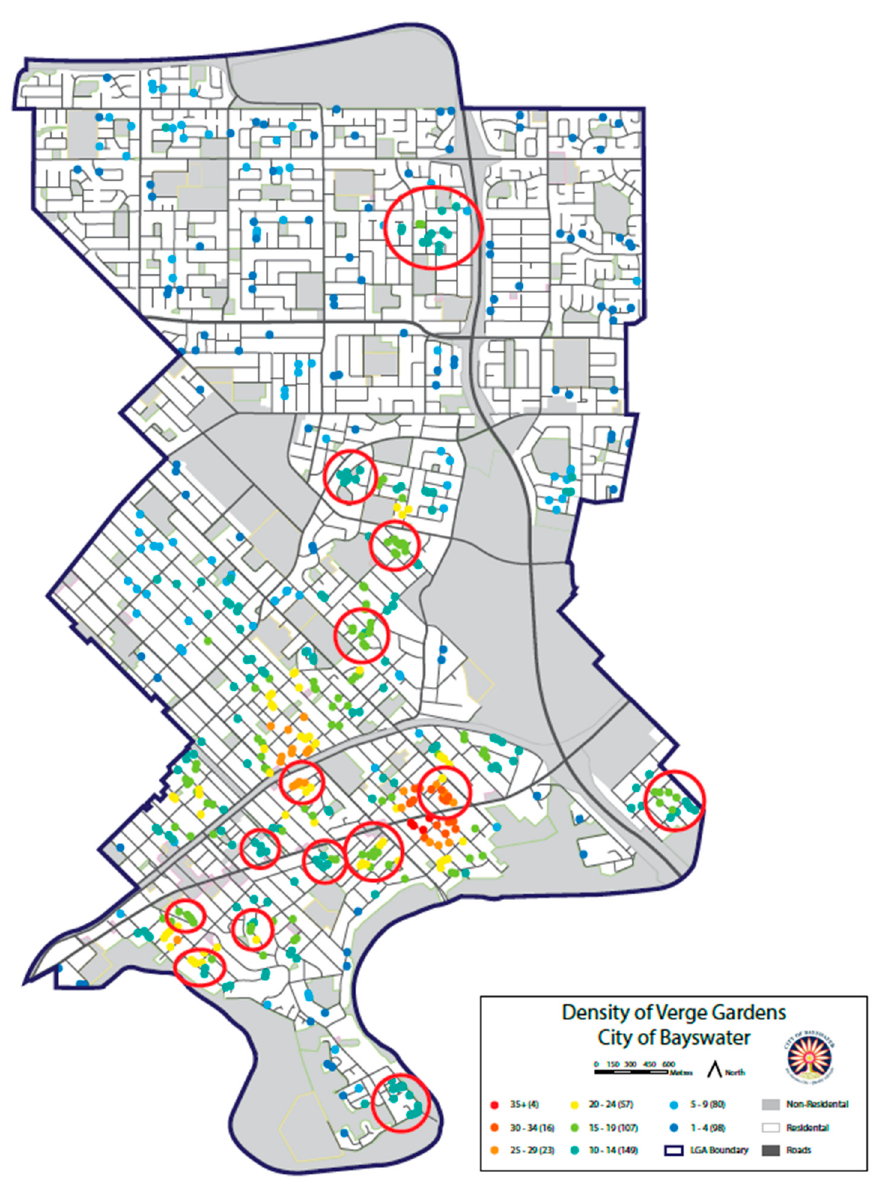
Figure 6. The density of verge gardens (per 400 m) within the City of Bayswater.